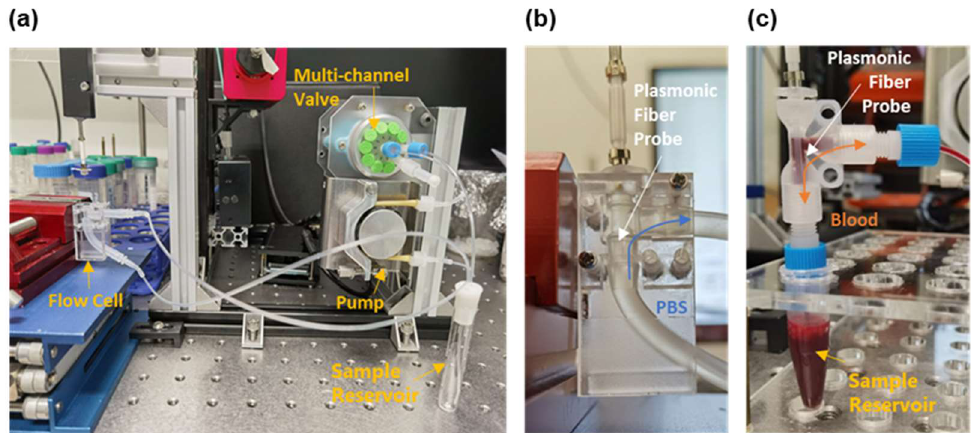
Figure 2. ( a ) Photograph of the homemade blood circulation mimicking system, which consists of a peristaltic pump, a multi-channel valve, a sample reservoir, and a flow cell that is 2.4 mm in diameter. Zoom-in view of the flow cell in ( a ) for calibration experiments using PBS ( b ) and the targeting experiments using whole mouse blood ( c ). In ( b , c ), the white arrows indicate the plasmonic fiber probe in the flow cell, the blue arrow denotes the flow direction of PBS, and the orange arrow represents the reciprocating direction of the blood flow. An additional sample reservoir is placed below the flow cell designed for blood ( c ) to buffer the reciprocating flow.